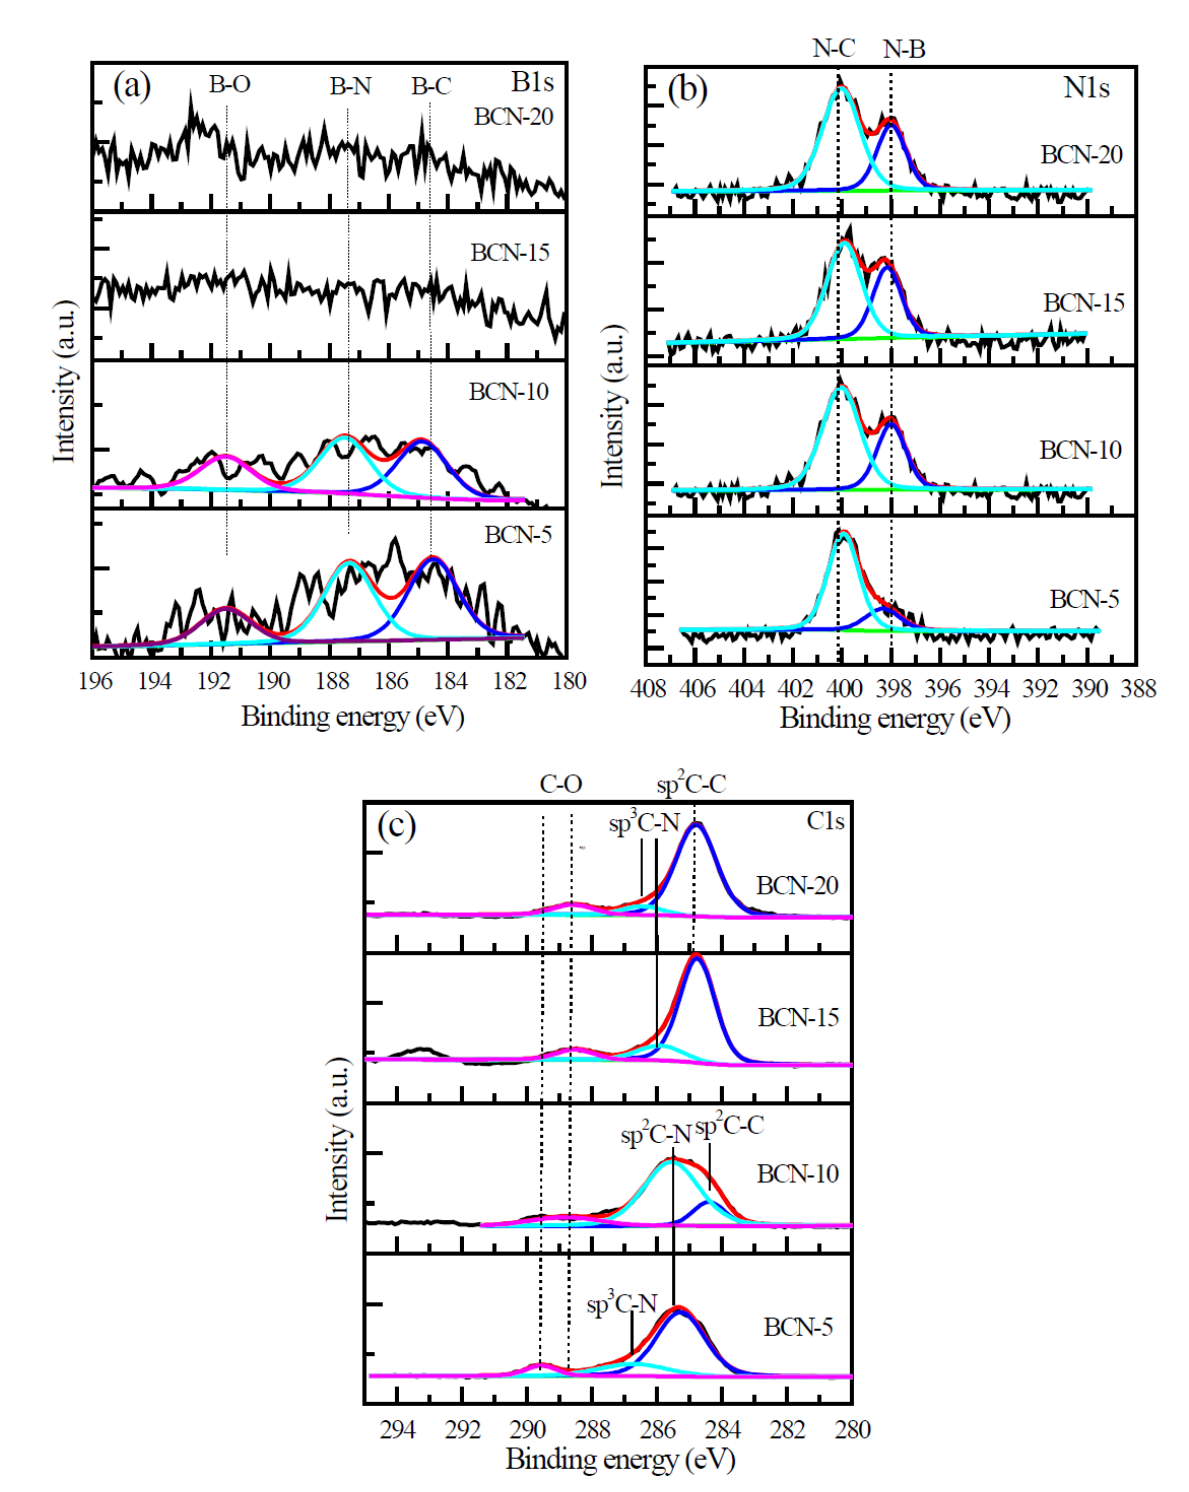
Figure 2: XPS spectra of BCN